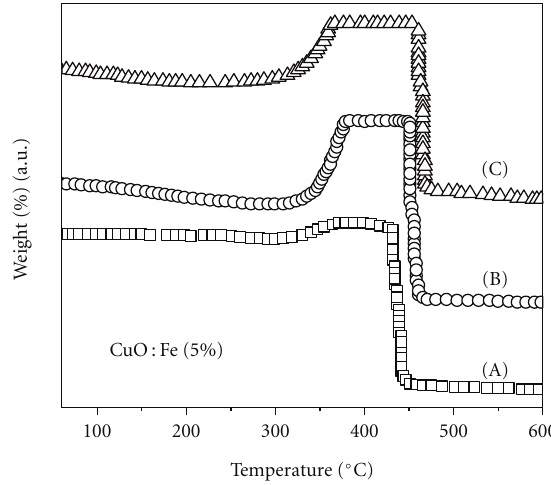
Figure 9: TGA results of samples: (A) bulk Cu 0 . 95 Fe 0 . 05 O, T N =